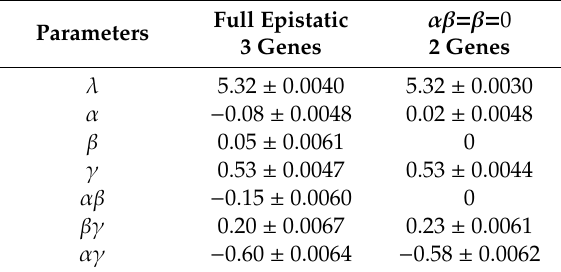
Table 8. Maximum likelihood estimates of allelic e ff ects and epistatic e ff ects in a two or three locus model of inheritance. The full epistatic model with three genes has three allelic e ff ects and three epistatic interactions. The two-gene model with gene B (Wrap) removed has two allelic e ff ects for A (WT) and C (Bulky) and two epistatic interactions between A (WT) and C (Bulky) and between B (Wrap) and C (Bulky). The standard errors were obtained from the square roots of the diagonal elements of the inverse of the information matrix N X (cid:48) AX .